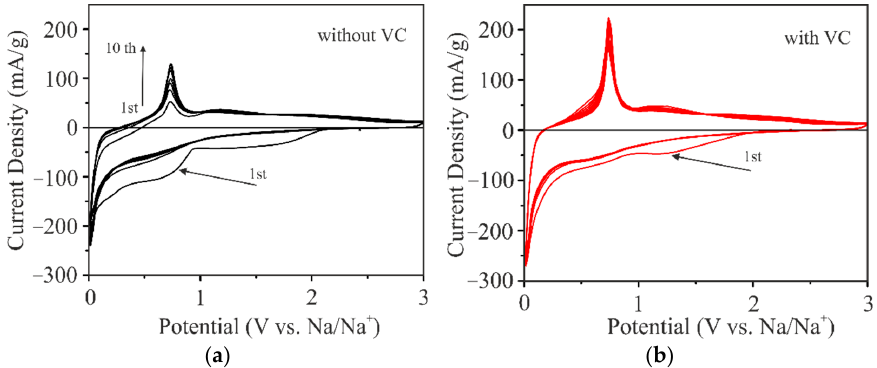
Figure 2 . CVs for Ge microrods in electrolyte without VC ( a ) and with VC ( b ) at the scan rate of 0.1 mV/s. Cycles numbers are shown in the plots.